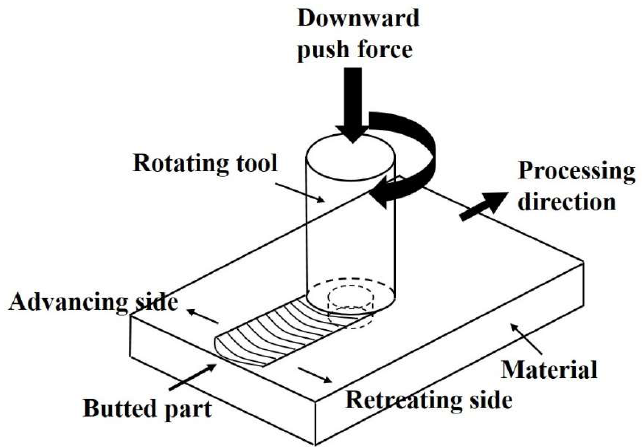
Figure 1. Schematic illustration of friction stir process (FSP).